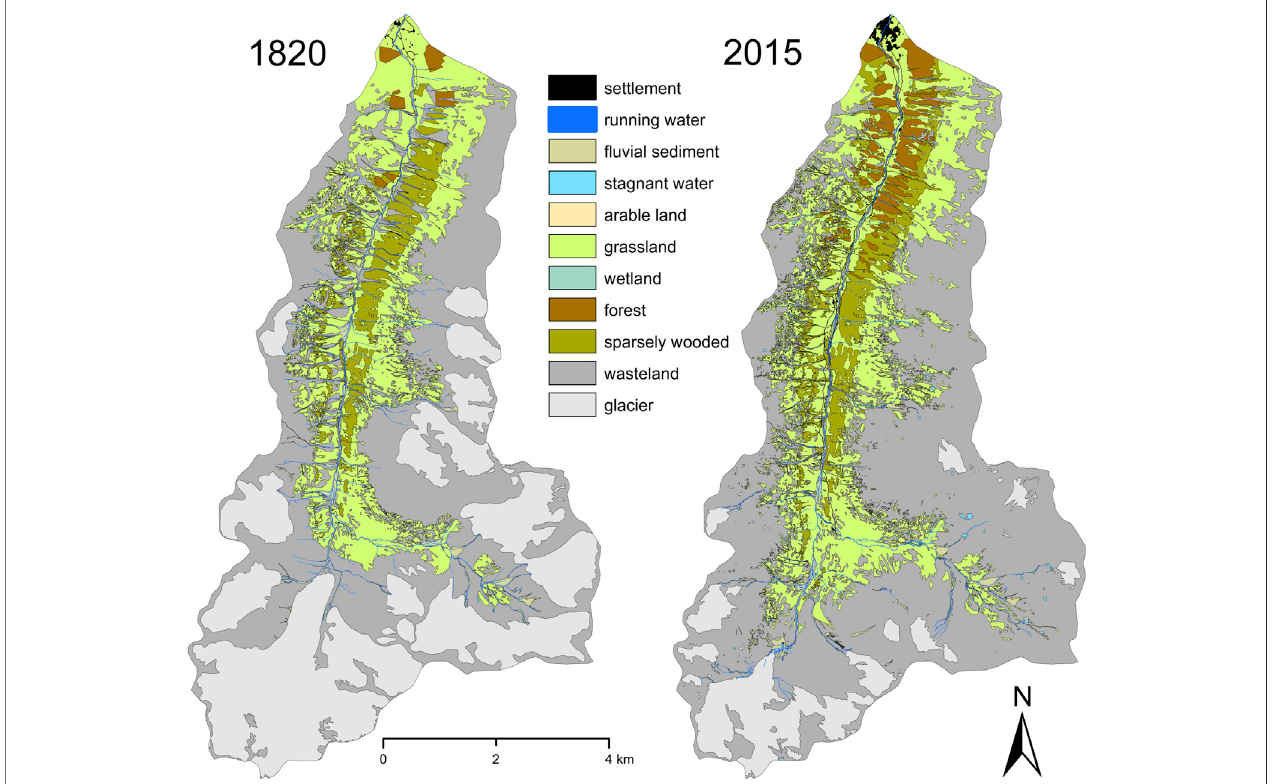
FIGURE 2 | Reconstructed land cover patterns in the Jamtal in 1820 and 2015 (width of running waters is magni fi ed).